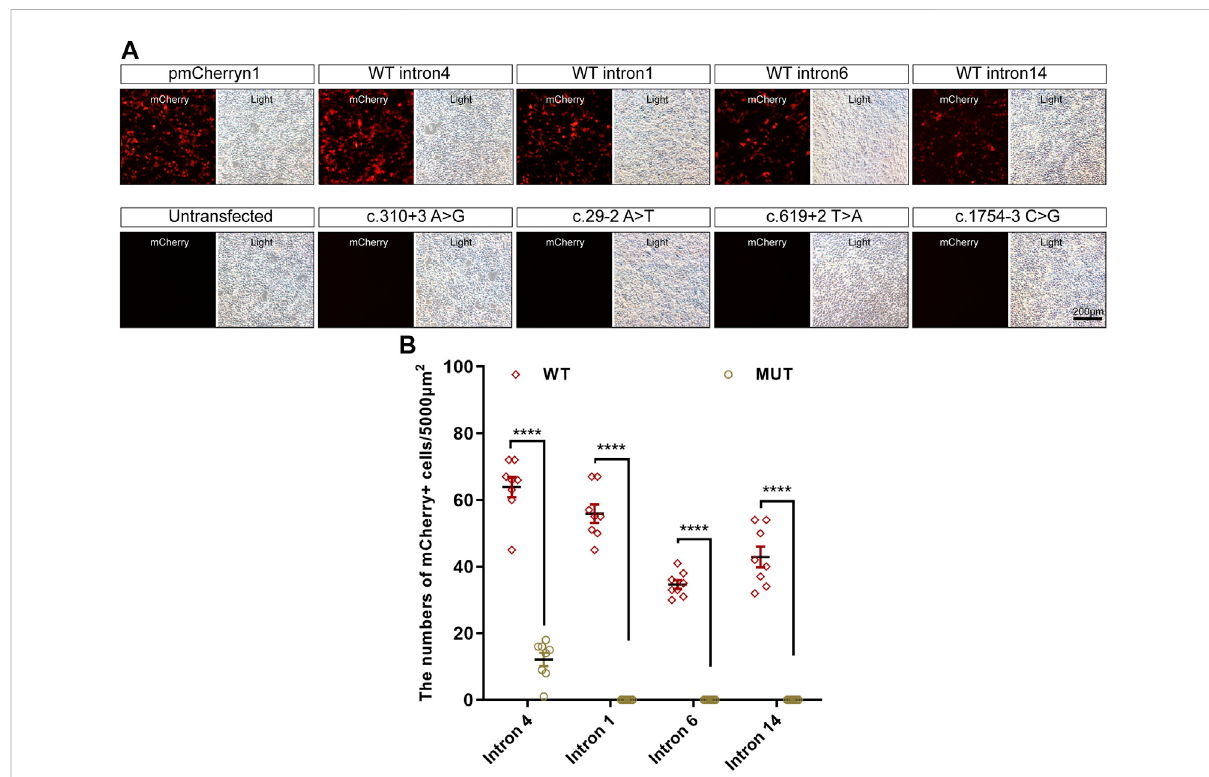
FIGURE 6 Expression of mCherry in in vitro splicing assays. (A) mCherry expression in HEK293T cells transfected with the pmCherryN1 vector containing WTormutantintrons,24haftertransfection;scalebar=200 μ m. (B) ThenumberofmCherry+cellsper5,000 μ m 2 inHEK293Tcellstransfectedwith mutant-intron-pmCherryN1 plasmids was statistically lower than that in 293T cells with WT-intron-pmCherryN1 plasmids. Error bars indicate the SEM, and the signi fi cance was calculated by a two-tailed unpaired t-test. **** p <